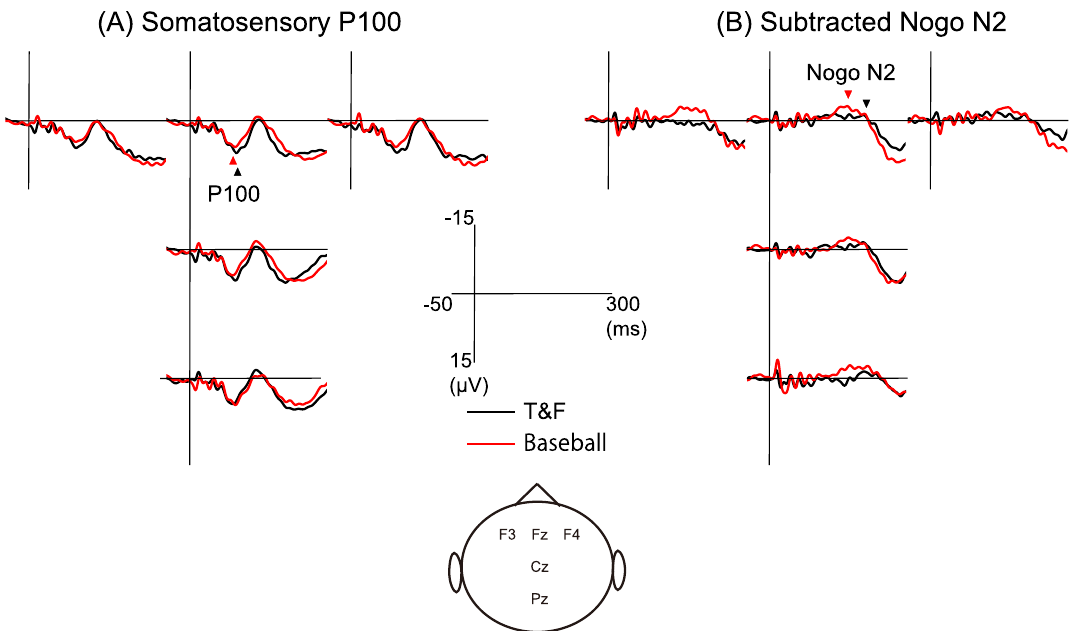
Figure 1. Grand averaged somatosensory P100 and subtracted Nogo N2. Grand averaged somatosensory P100 for Go trials ( A ) and subtracted Nogo N2 ( B ) in the T&F and baseball groups. The black and red triangles show the peak latency of each component in the T&F and baseball groups,